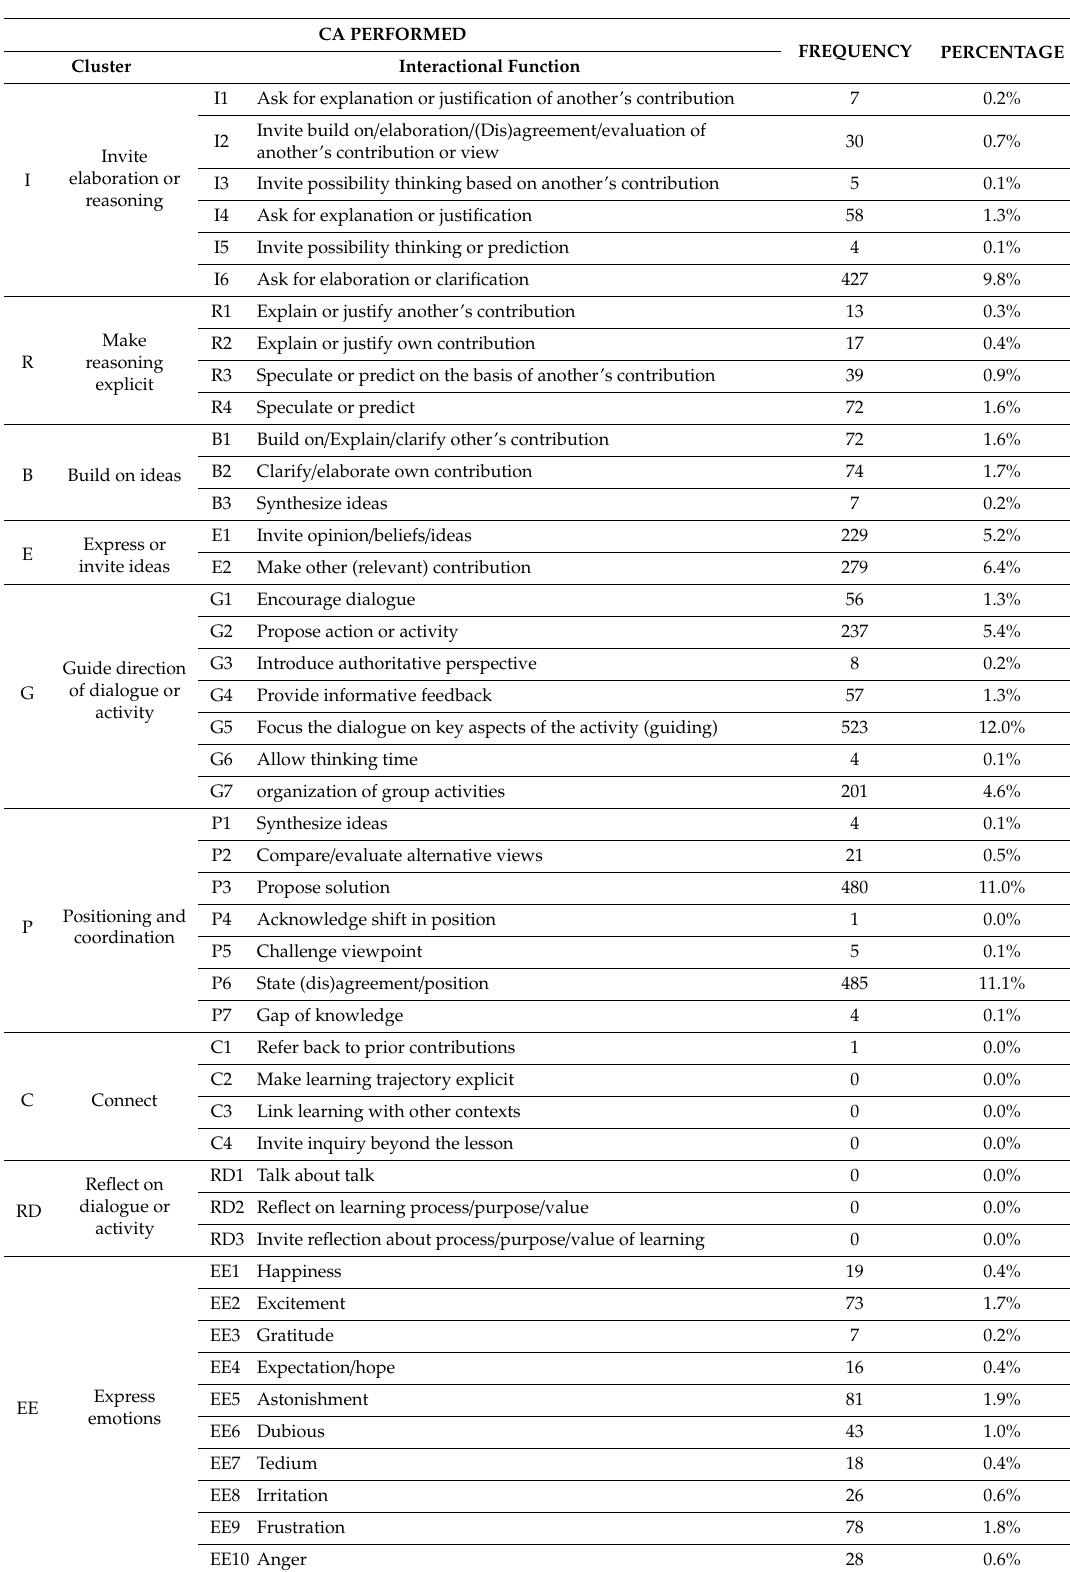
Table 2. Performed communicative acts